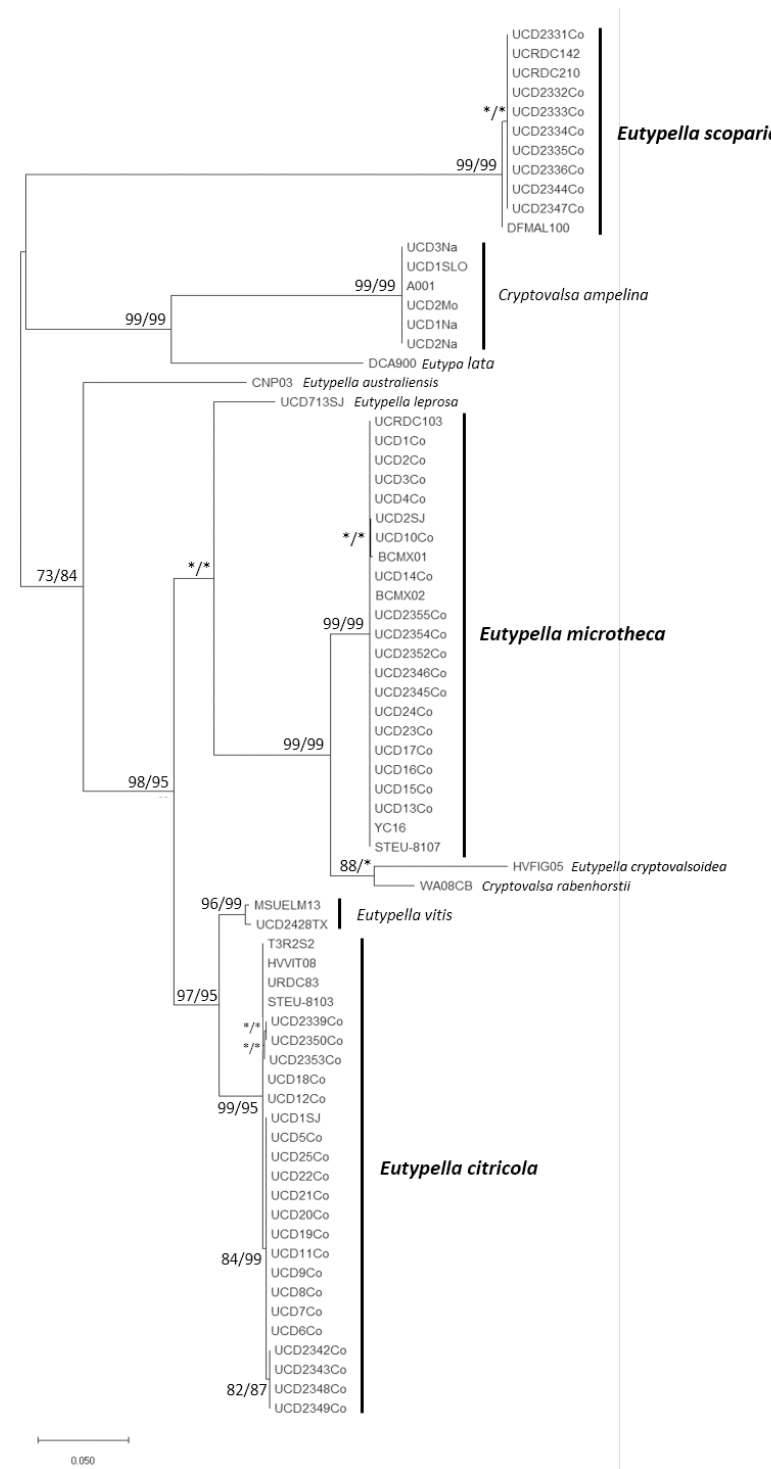
Figure 5. Greatest log likelihood Neighbor-Joining phylogenetic tree of the combined ITS and TUB2 tree generated with 72 Diatrypaceae nucleotide sequences. Numbers in front and after the slashes represent, respectively, likelihood and parsimony bootstrap values from 1000 replicates. Values accompanied by an asterisk were less than 70% bootstrap. Eutypella isolates from spore traps from this study are indicated in bold